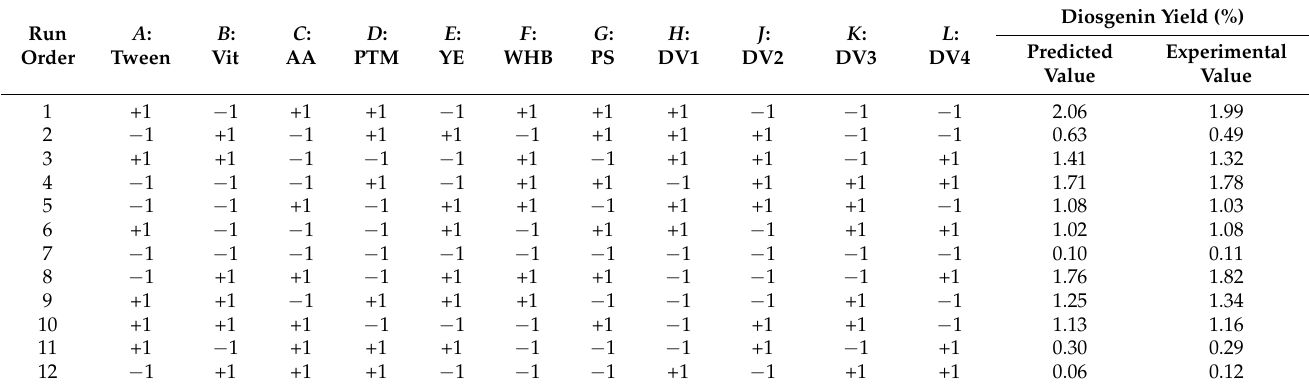
Table 1. Diosgenin yield under various submerged fermentation (SmF) conditions in Plackett–Burman design (PBD) matrices.